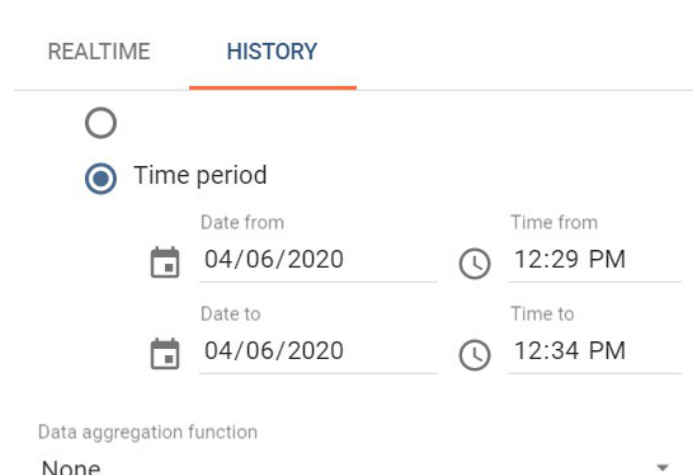
Figure 5. Real-time data.